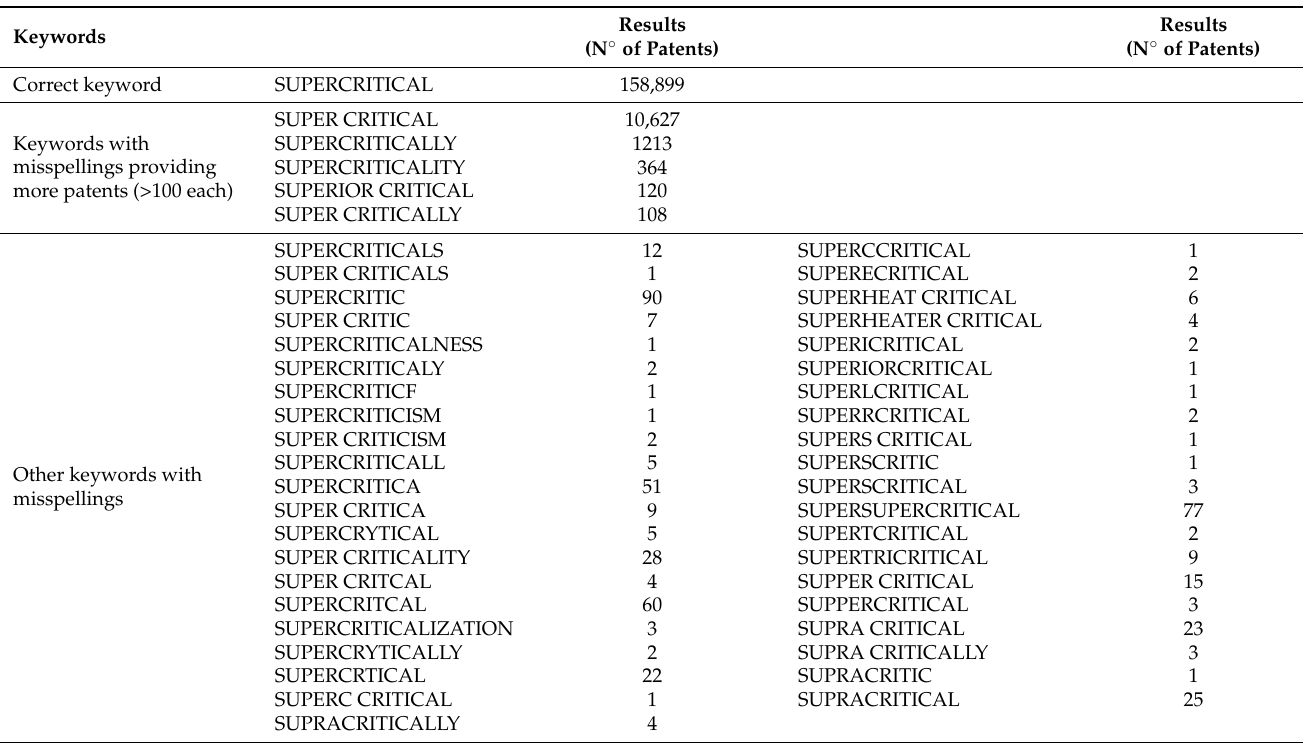
Table 10. Keywords (correct and with misspellings) used to search patents about SUPERCRITICAL